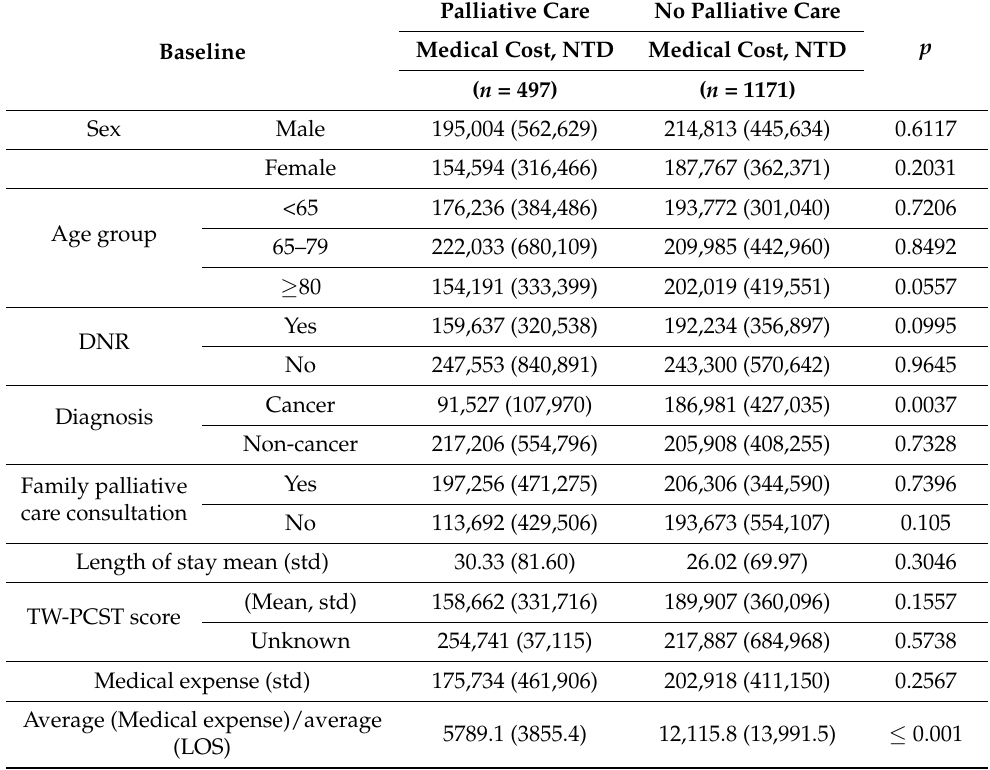
Table 3. Medical costs with and without palliative care.